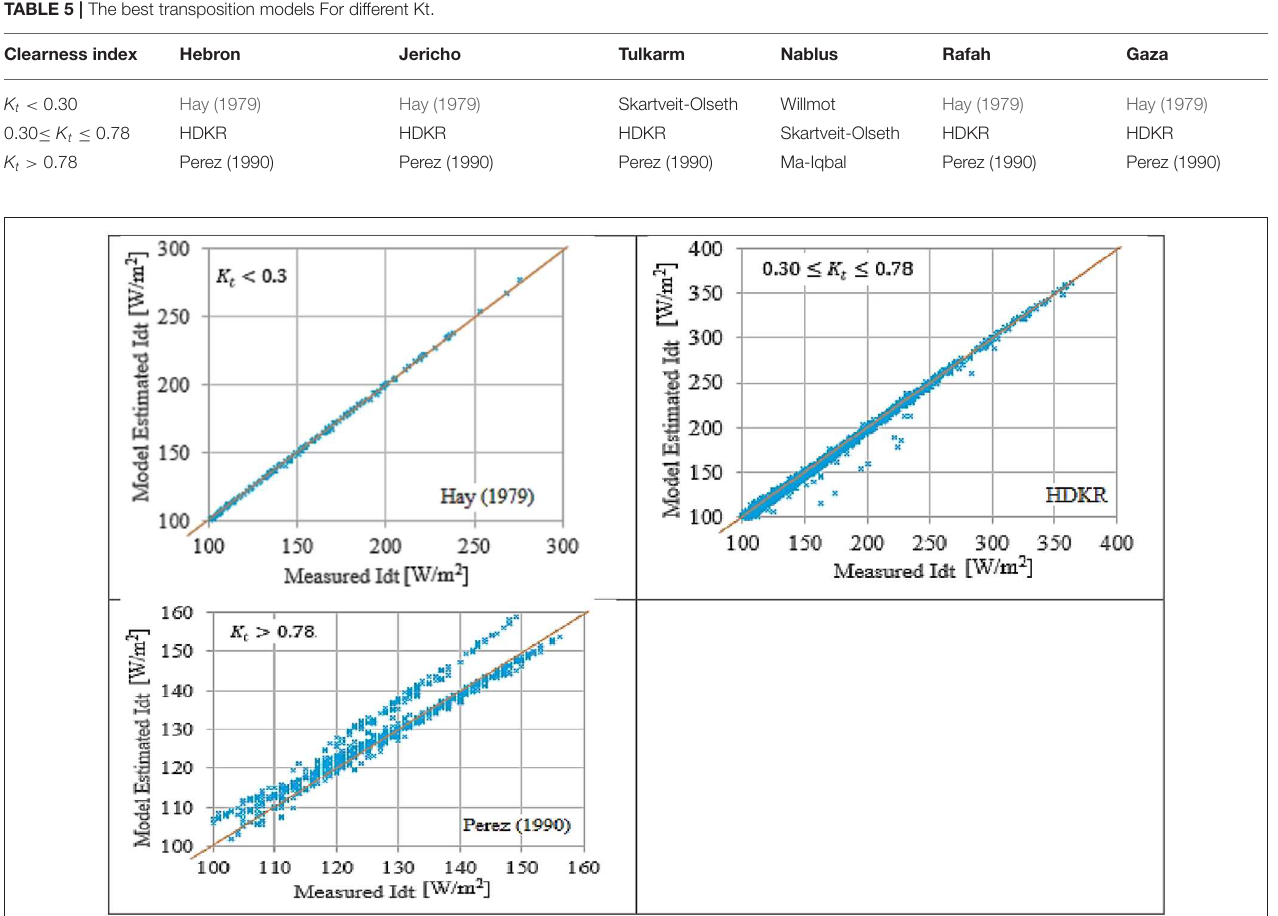
irradiance data. Therefore, evaluating the performance of the dominant transposition models is elementary in determining the appropriate database and solar